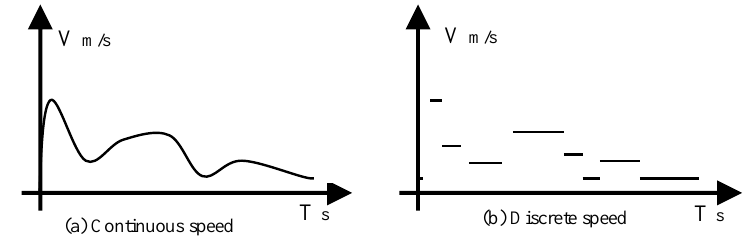
Figure 3. Type of moving speed of mobile sink (MS) in continuous form and converted into a discrete one.